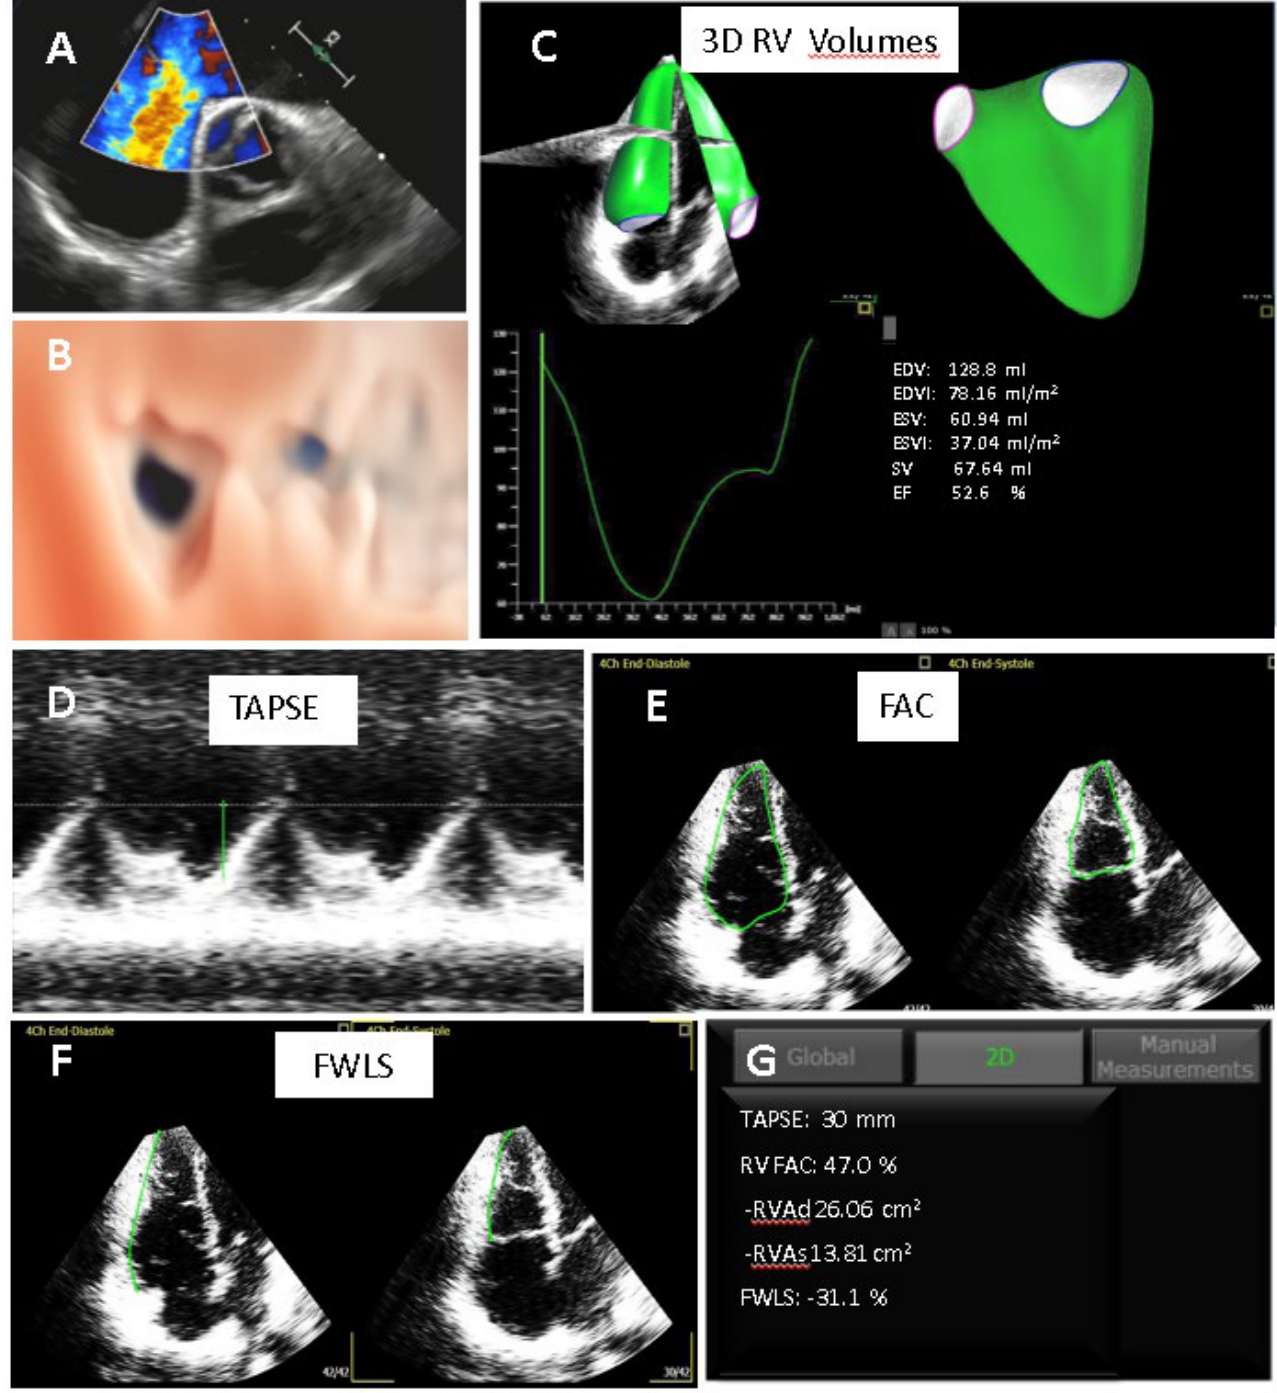
Figure 4. Patient with an ostium secundum ASD. ( A ) TEE showing a significant left–to–right shunt at the atrial level. ( B ) oval shape ASD at transthoracic 3D echo (right atrial view); ( C ) AI 3DTTE volume and function curves and analysis demonstrating moderate dilation of the RV normal RV systolic function. ( D – G ) automated analysis of TAPSE, FAC and RVLS obtained by 3D dataset. ASD: atrial septal defect; TEE: transesophageal echocardiography; TTE: transthoracic echocardiography; TAPSE: tricuspid annular plane systolic excursion; FAC: fractional area change; FWLS: free wall longitudinal